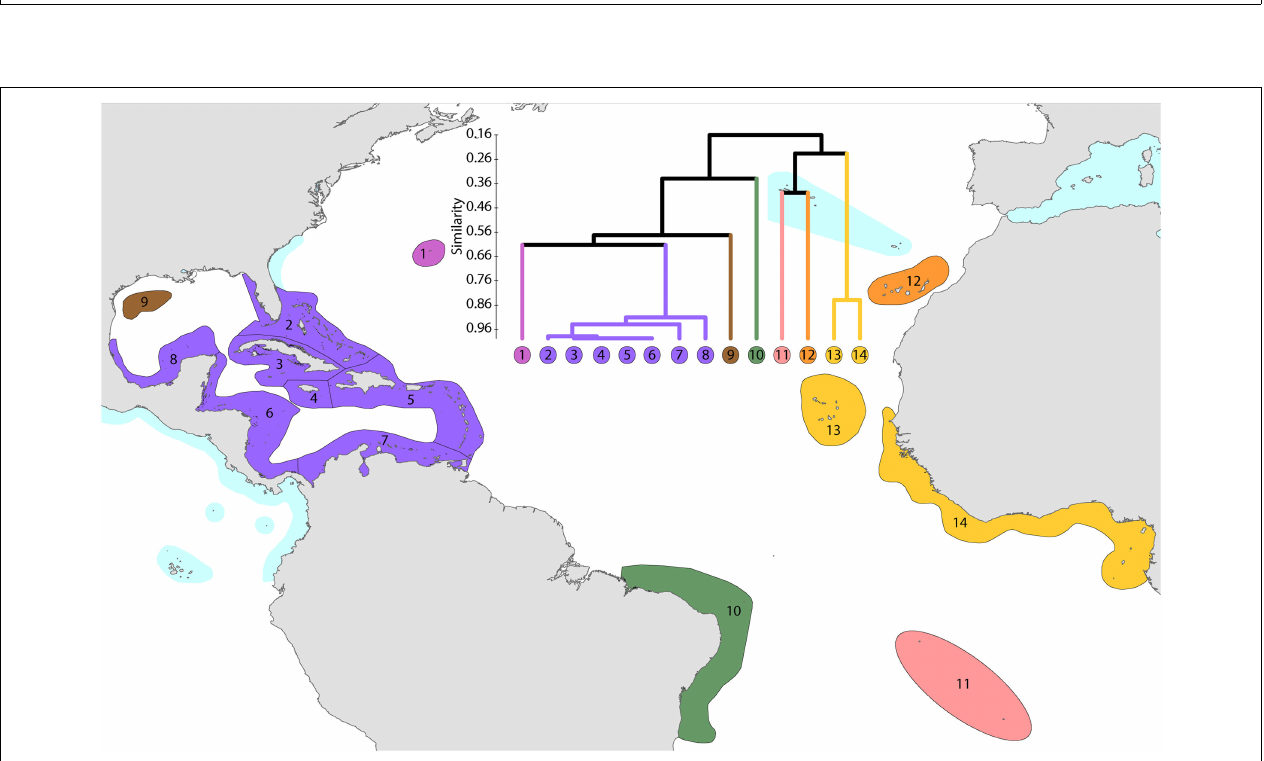
FIGURE 14 | Affinity and diversity of ecoregions of the Atlantic Ocean. This dendrogram was produced by the progressive exclusion of outlying ecoregions; there were no internal exclusions. See Supplementary Material 1: “List of ecoregions and associated data” for number of species within ecoregions.